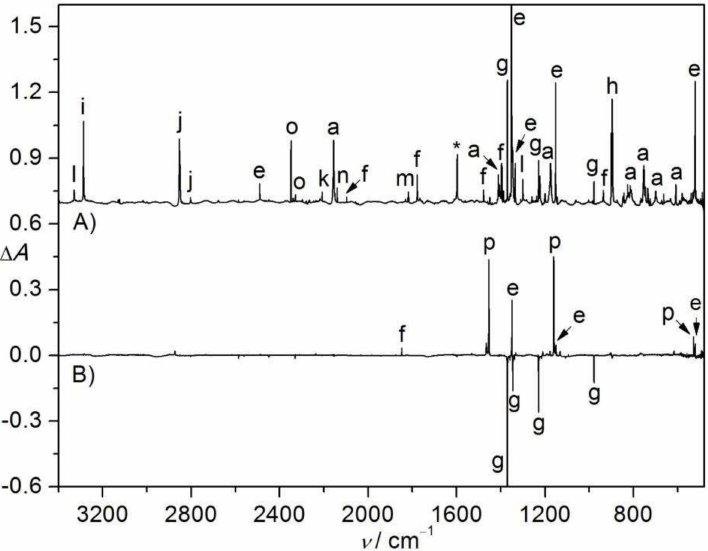
Figure 4. ( A ) IR spectrum (Absorbance, A ) of the N 2 -matrix isolated flash vacuum pyrolysis (700